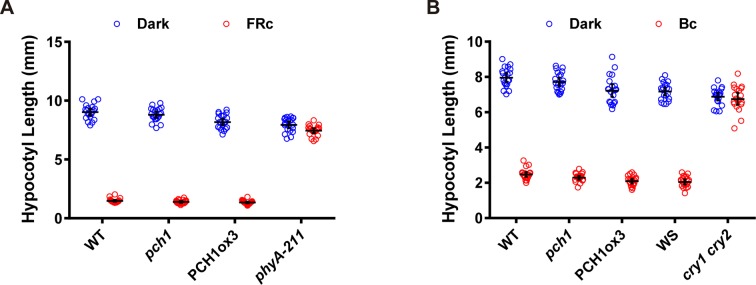
pch1 does not affect far-red or blue light mediated hypocotyl elongation.(A) Hypocotyl measurements of 4-day-old WT, pch1, PCH1ox3 and phyA-211 seedlings grown under either dark or constant far-red light conditions (FRc, 25 µmol·m-2·s-1). Mean ± 95% CI (n = 20). (B) Hypocotyl measurements of 4-day-old WT (Col), pch1, PCH1ox3, Wassilewskija (WS) and cry1 cry2 (in WS) seedlings under either dark or constant blue light conditions (Bc, 20 µmol·m-2·s-1). Mean ± 95% CI (n = 20).